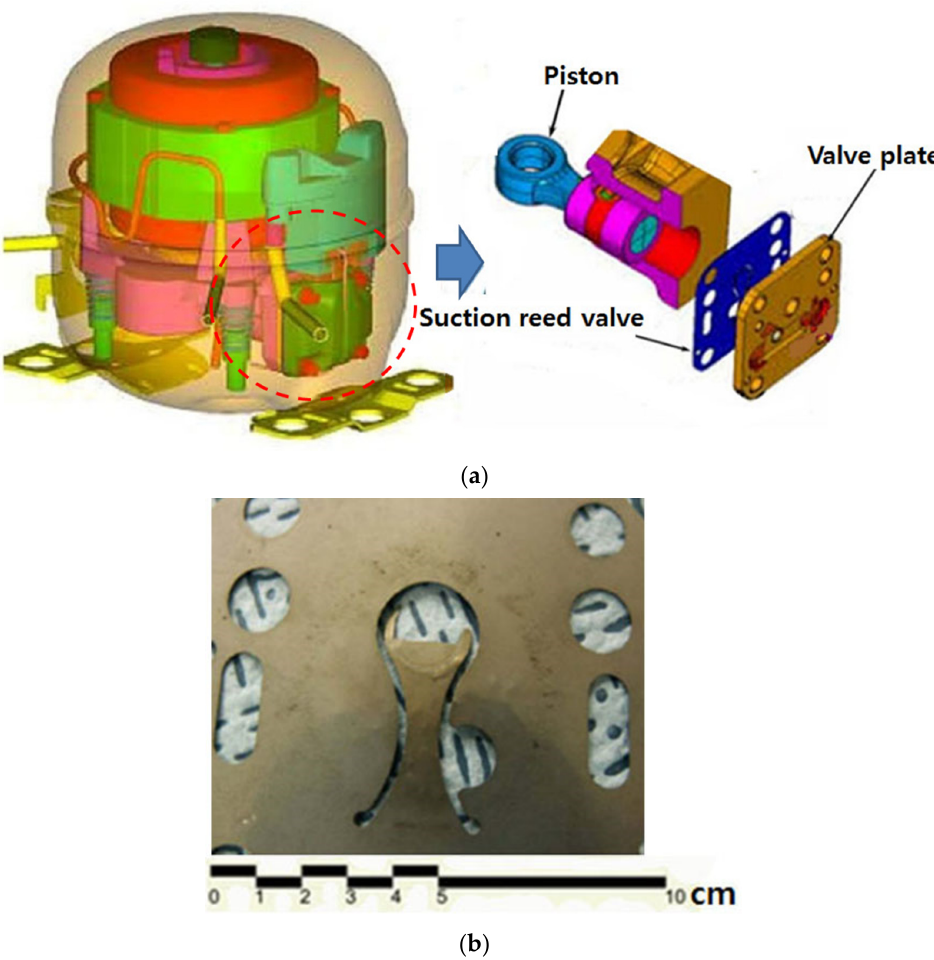
Figure 7. Failed suction reed valve: ( a ) suction reed valve and valve plate in a compressor. ( b ) Frac- tured suction reed valve from the marketplace or parametric ALT.